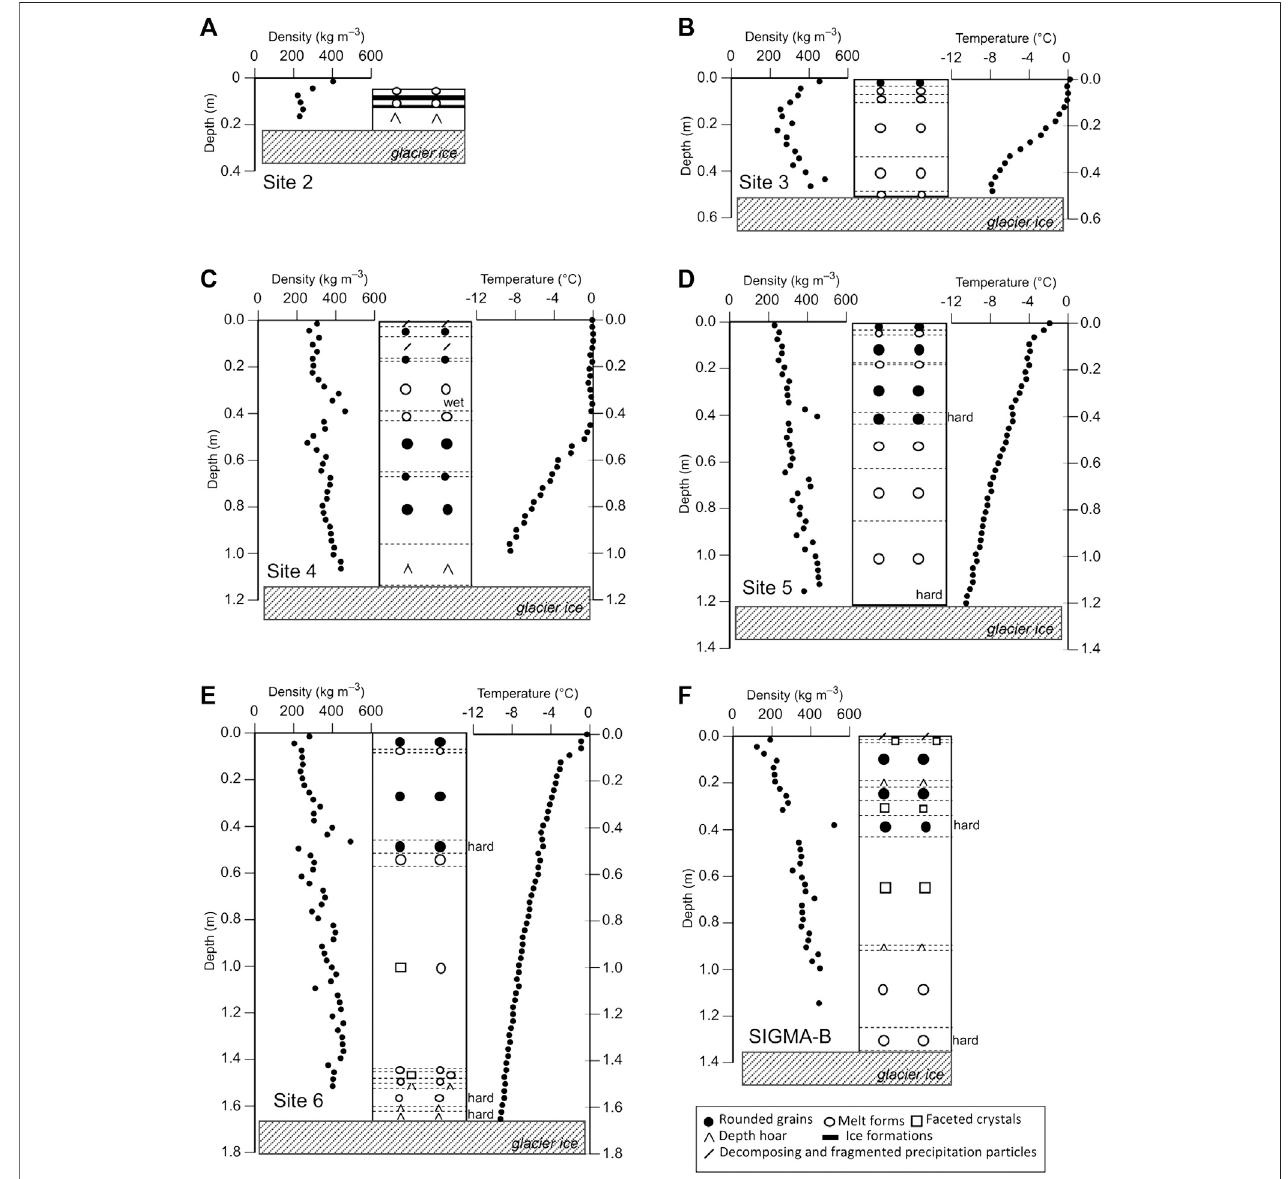
FIGURE 2 | Snow stratigraphy and vertical pro fi les of snow density and snow temperature in snow pits at sites 2 – 6 (A – E) and SIGMA-B site (F) . The characters showing snow classi fi cation of stratigraphy are following by the snow classi fi cation by Fierz et al. (2009). Shading areas represent glacier ice under seasonal snow layer. “ hard ” represents relatively hard snow layer. “ wet ” in fi gure c represents a snow layer containing liquid water.